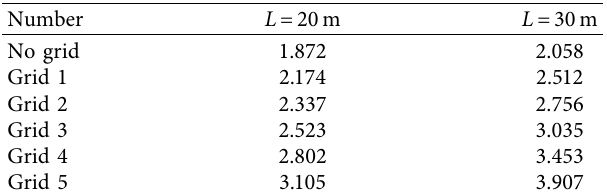
Table 2: Comprehensive resistance coefficients of various